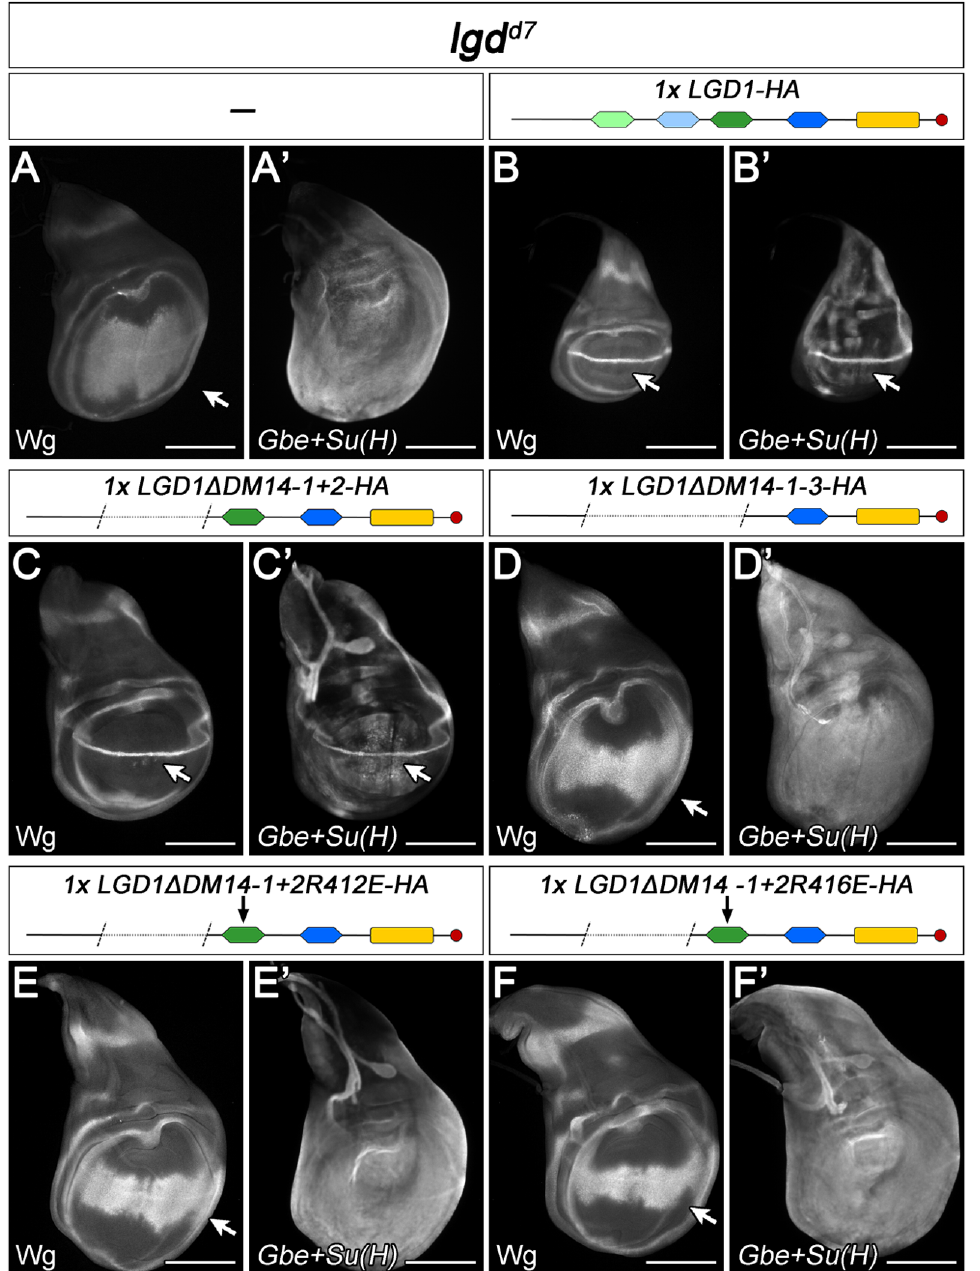
Figure 4. Analysis of the LGD1-Shrub interaction interface. ( A , A’ ) Expression of Wg and the Notch activity reporter Gbe+Su(H) in lgd mutant discs. The expression Wg is expanded (arrow in A), while the expression of Gbe+Su(H) is expressed in all disc cells. ( B , B’ ). The presence of one copy of lgdP-LGD1 results in a complete rescue, indicated by the normalisation of Wg expression and the pattern of Gbe+Su(H) expression. ( C , C’ ) The presence of LGD1 ∆ DM14-1+2 results in a partial rescue of lgd mutants, indicated by the remaining weak ectopic expression of the Notch targets (arrows). ( D , D’ ) LGD1 ∆ DM14-1-3 has no rescue ability, indicated by the lgd mutant phenotype of the discs (compare with A, A’). This shows that the odd-numbered DM14-3 is responsible for the rescue of LGD1 ∆ DM14-1+2. ( E – F’ ) The rescue ability of LGD1 ∆ DM14-1+2 is abolished if one of the two positively charged residues within DM14-3, which mediate the interaction between protomers is exchanged to E (R412 or R416). Scale bars 200 µ m. At least ten wing imaginal discs were analysed for each